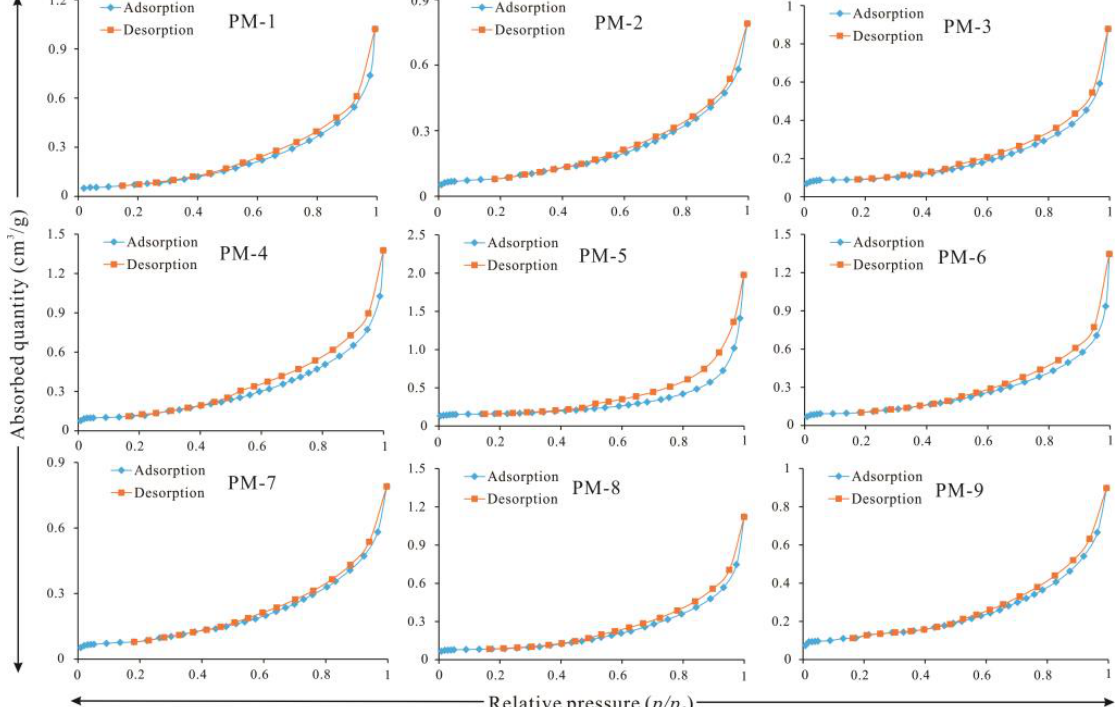
Figure 5. N 2 adsorption isotherm of ten samples at 77 K.